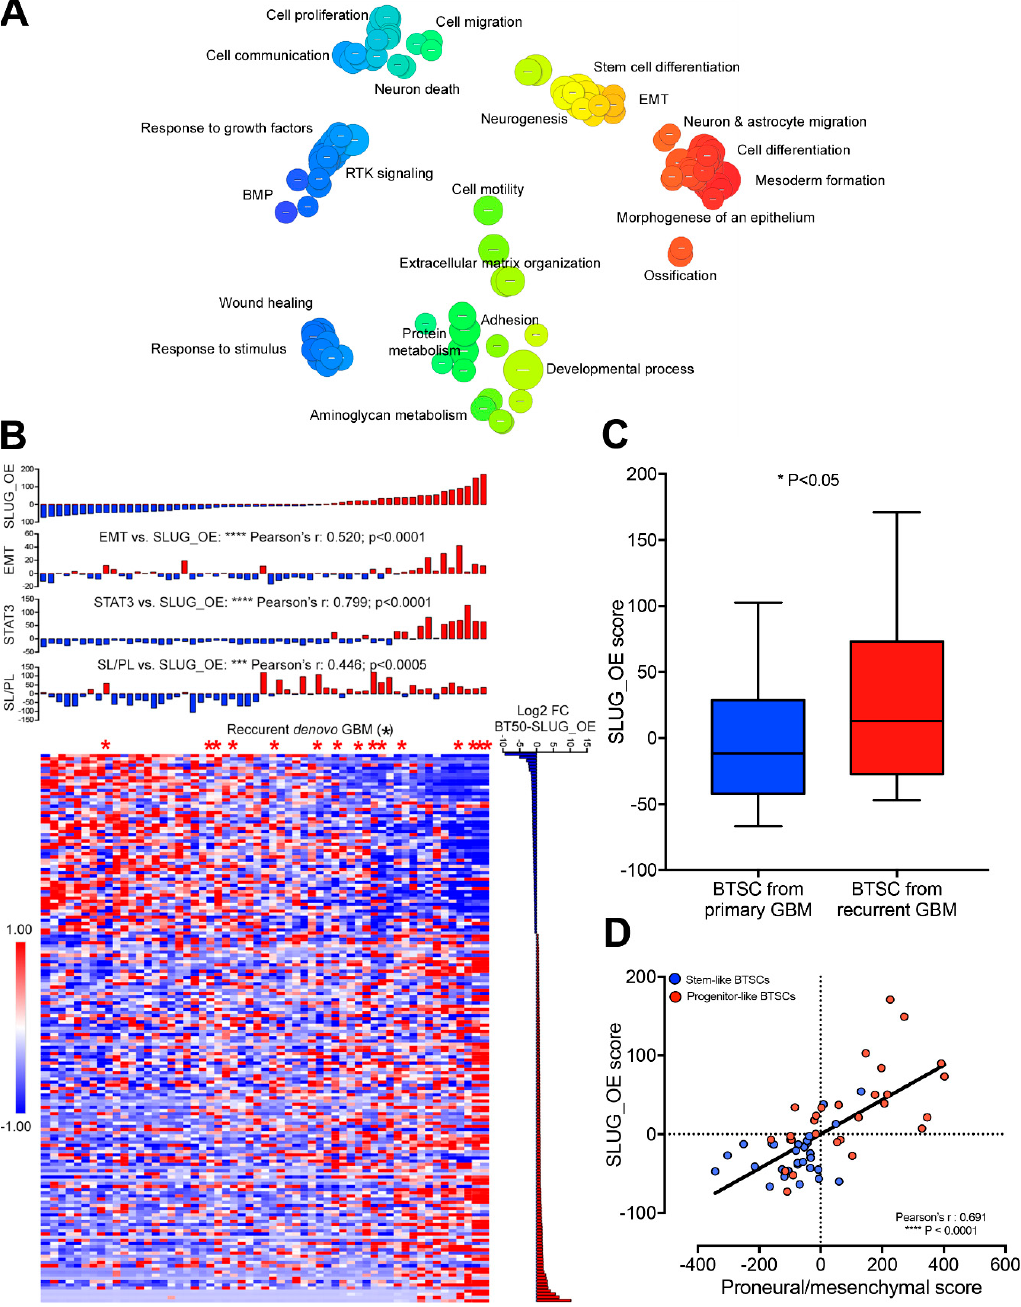
Figure 7. SLUG-induced transcriptional changes are associated with progenitor-like BTSC precursor state and recurrence (see also Table S2). ( A ) Revigo visualization of Gene Ontology analysis from RNA sequencing performed on BT50 CTRL and SLUG_OE cells. ( B ) Heatmap of the 180 differentially expressed genes between BT50 CTRL and SLUG_OE cells in the 57 BTSCs and bar graphs of their respective SLUG_OE, stem-like to progenitor-like (SL / PL), STAT3, and EMT scores (asterisk mark BTSCs from recurrent primary GBMs). ( C ) Box and whiskers plot (min to max) representing the SLUG_OE score of BTSCs that were derived from primary GBMs compared to those derived from recurrent GBMs (exclusively from de novo GBMs). ( D ) Scatter plot of SLUG_OE score versus proneural to mesenchymal